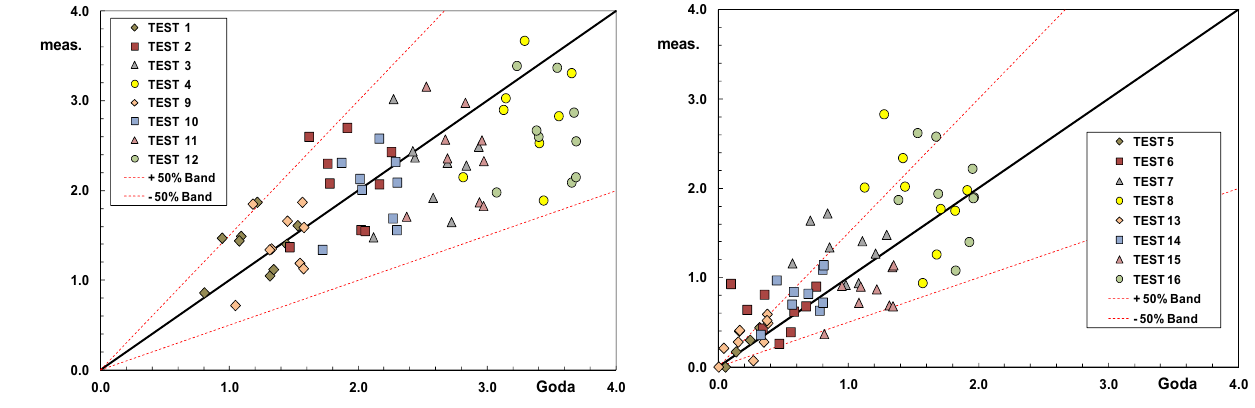
Figure 11. Measured p vs. predictions of the Goda formula. Left panel: Front waves; 1/250 right panel: side waves. Data in kN/m 2